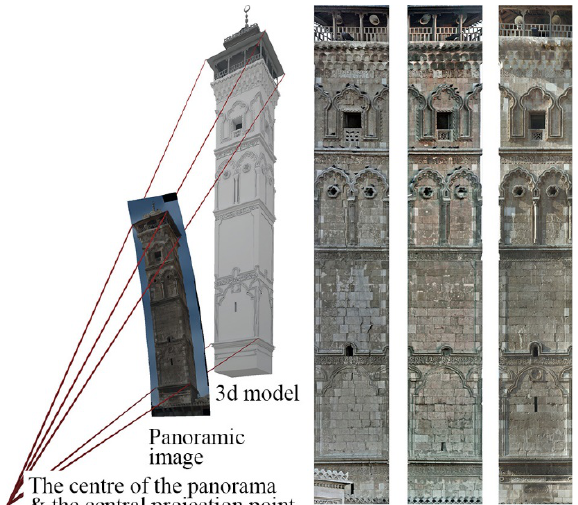
Figure 3. Based on the spatial projection of the oriented panoramas on primitive geometries, it is possible to create the 3d model and to extract